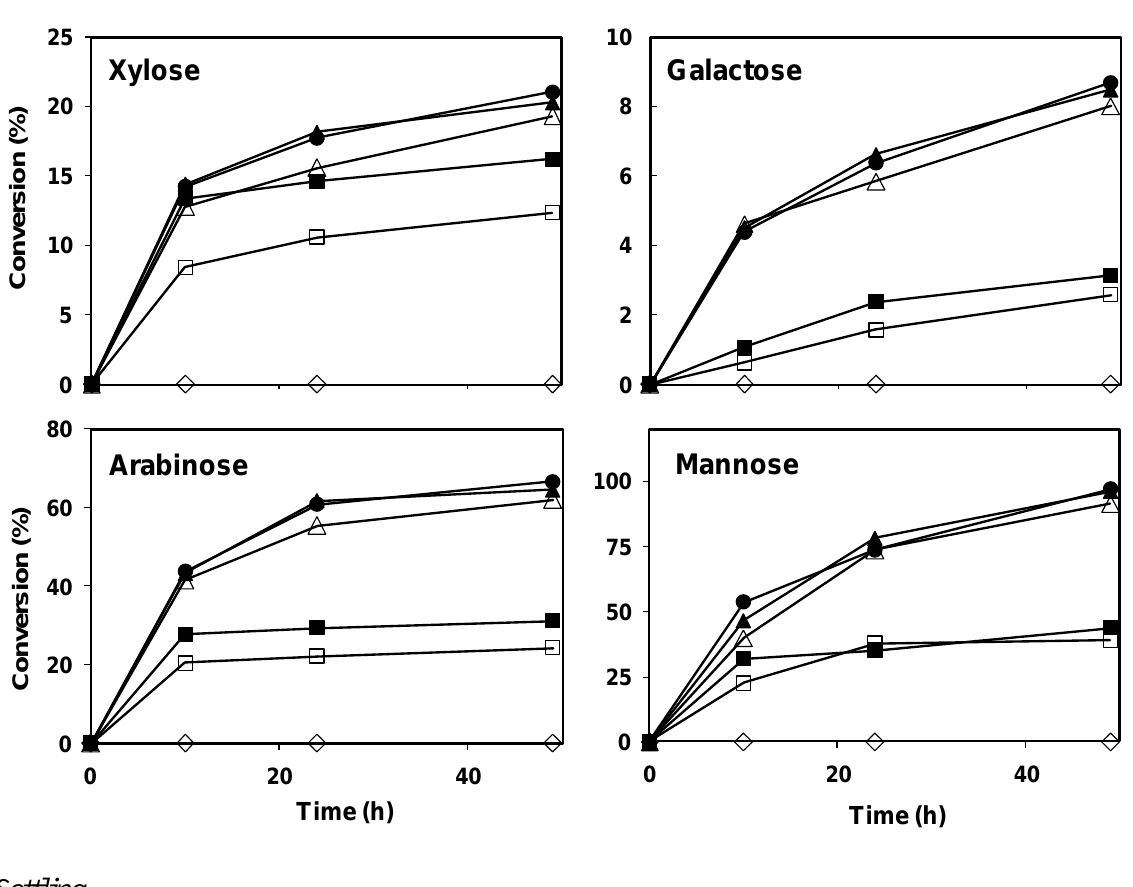
Figure 2. Effect of cellulase, β-glucosidase and hemicellulase on hemicellulose of flesh solid. Data is presented as yield of hydrolysis: gram of converted polymeric sugar to gram of initial hemicellulose. The presented results are averages of the two replicates. Average standard deviation is 3.1%, 3.8%, 1.1% and 0.8% for xylose, galactose, arabinose and mannose, respectively. Figure legend: (□) Cellulase 20 FPU; (■) Cellulase 50 FPU; (∆) Cellulase 20 FPU, β-glucosidase 50 IU; (▲) Cellulase 50 FPU, β-glucosidase 50 IU; (  ) Cellulase 50 FPU, β-glucosidase 50 IU, hemicellulase 20 U; (◊) Hemicellulase 20